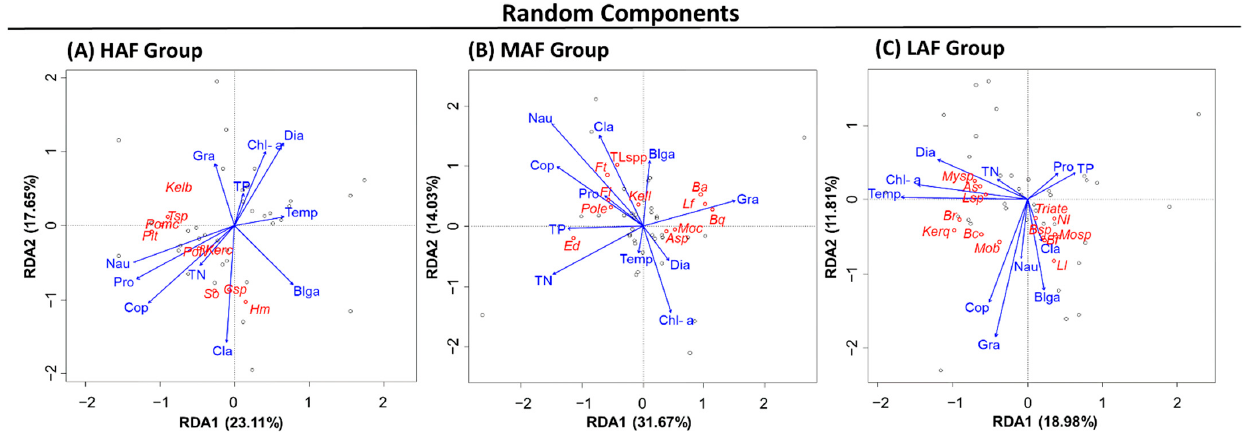
Figure 8. Redundancy analysis of the random component (derived from the time series of the abundance estimates of three rotifer groups) and environmental factors. ( A ) High abundance and frequency rotifers group, ( B ) Middle abundance and frequency rotifers group, ( C ) Low abundance and frequency rotifers group.